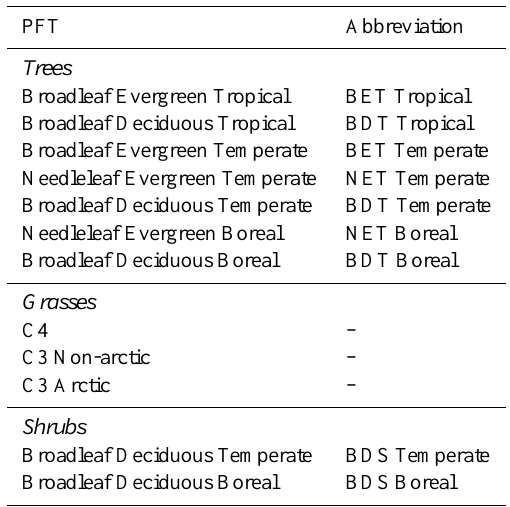
Table 1. Plant functional types (PFTs) used for parameter